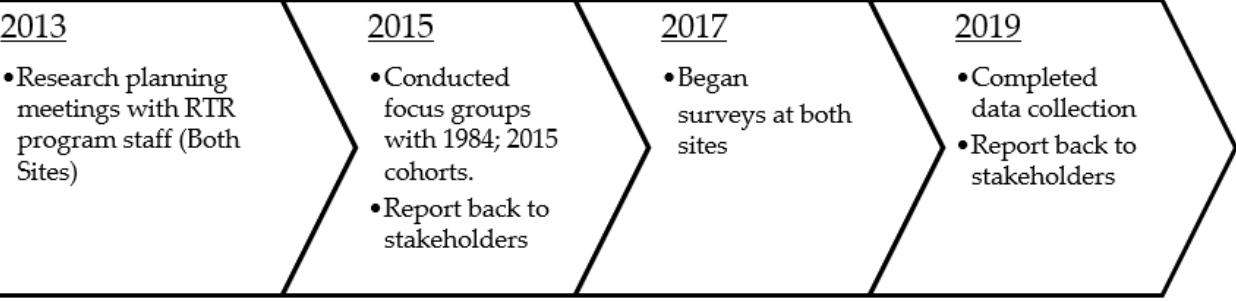
Figure 1. Remember the Removal Program Evaluation Project Timeline.